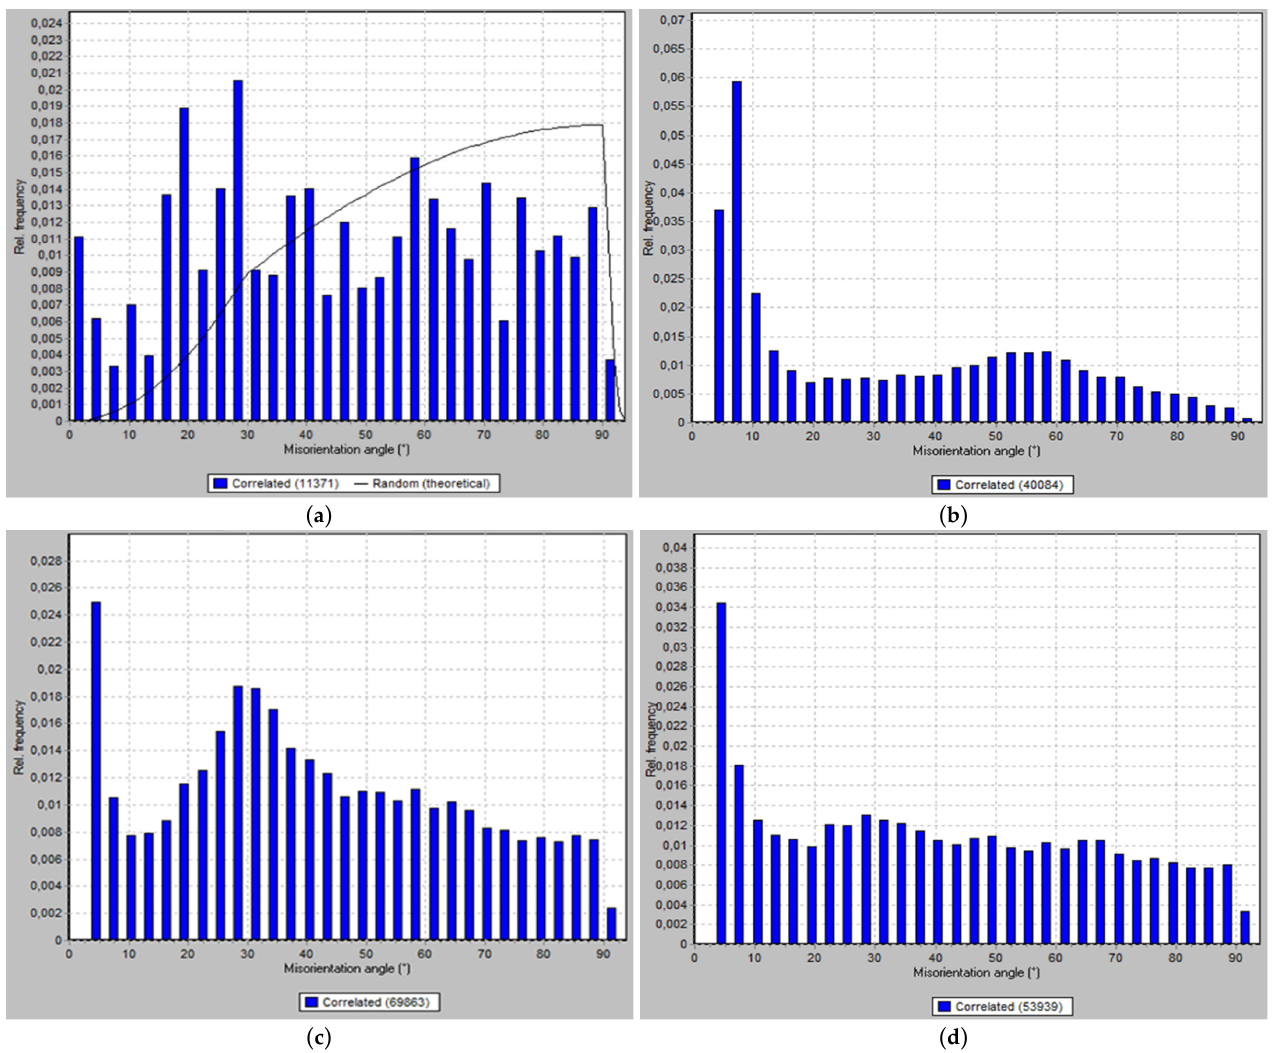
Figure 7. Misorentation angle distribution histograms obtained from the EBSD data for ( a ) AA and ECAPed billets processed through ( b ) 1-P, ( c ) 2-Bc, and ( d ) 4-Bc.